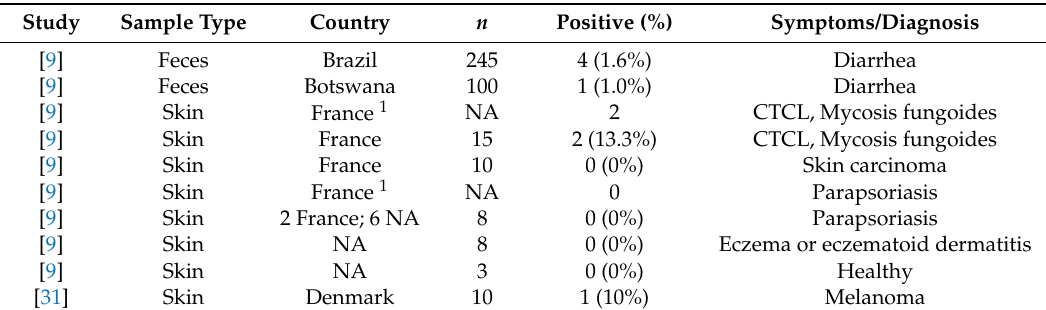
Table 3. CuV DNA prevalences in fecal and skin